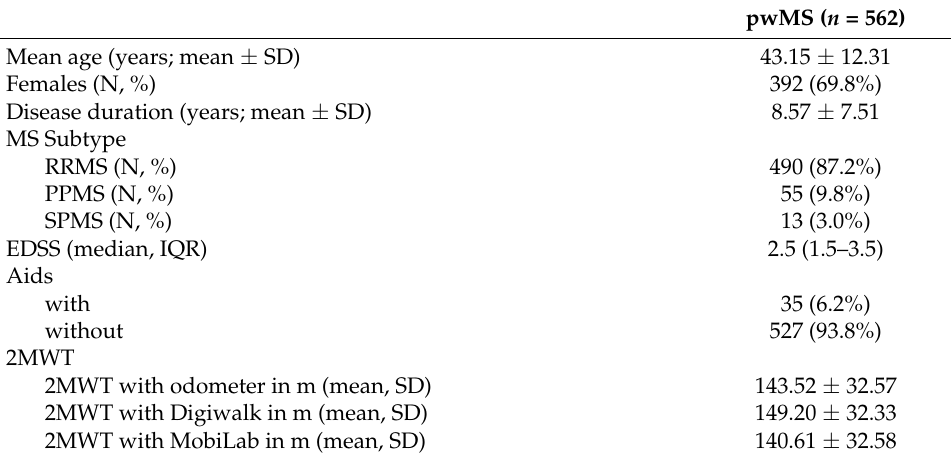
Table 1. Characterization of people with multiple sclerosis (MS) presented as mean [mean] with standard deviation [SD] or median with interquartile range (IQR); MS = multiple sclerosis; RRMS = relapsing–remitting MS; PPMS = primary progressive MS; SPMS = secondary progressive MS; EDSS = Expanded Disability Status Scale; 2-min walk =